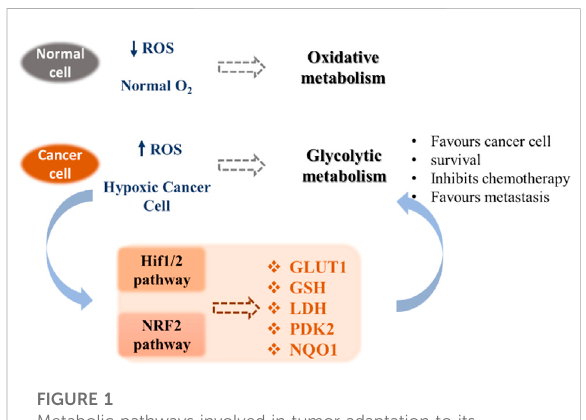
FIGURE 1 Metabolic pathways involved in tumor adaptation to its stressful environment (Gaiddon et al.,